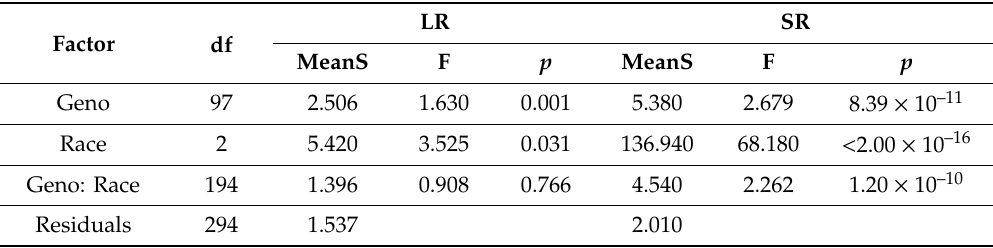
Table 4. ANOVA of plant genotype (Geno), pathogen race (Race), and plant genotype × pathogen race (Geno: Race) e ff ects on seedling resistance to leaf rust (LR) and stem rust (SR) in the Pamyati Azieva × Paragon mapping population.